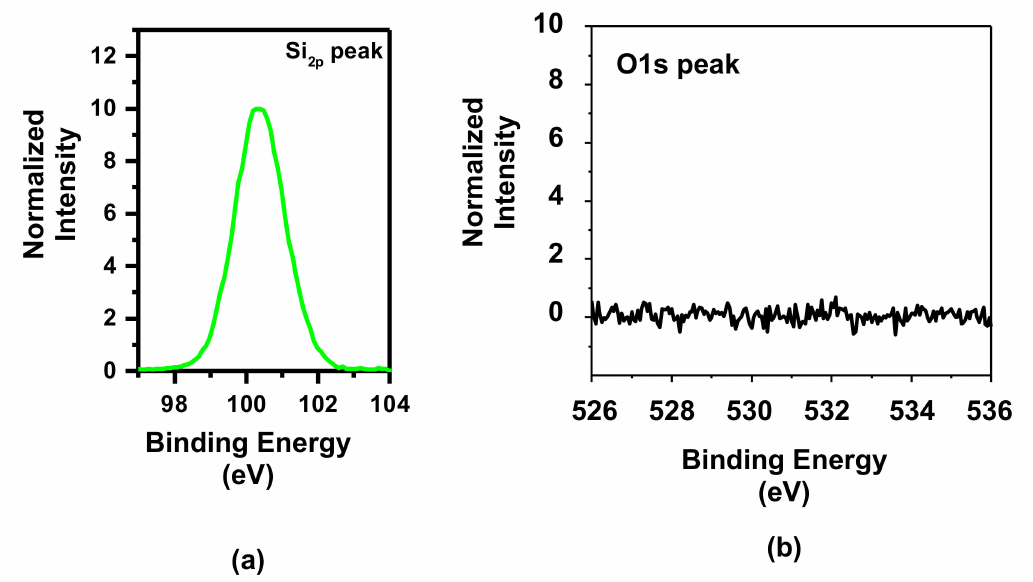
Figure 3. Representative high-resolution XPS spectra of: ( a ) Si2p binding energy for SiC films deposited at 850 ◦ C, corresponding to stoichiometric Si:C; and ( b ) O1s binding energy for SiC films deposited at 850 ◦ C, indicating the absence of any O contamination.